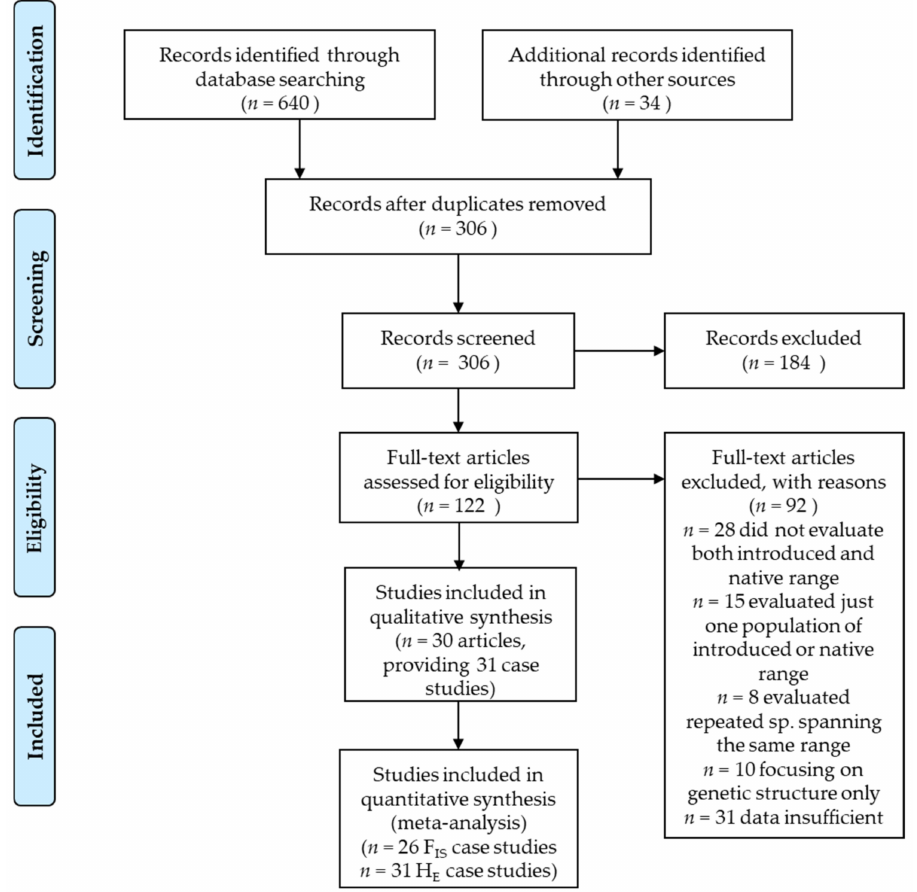
Figure 1. Flowchart of preferred reporting items for systematic reviews and meta-analysis (PRISMA), summarizing the sequence of information selected for this meta-analysis. n refers to the number of case studies used in each